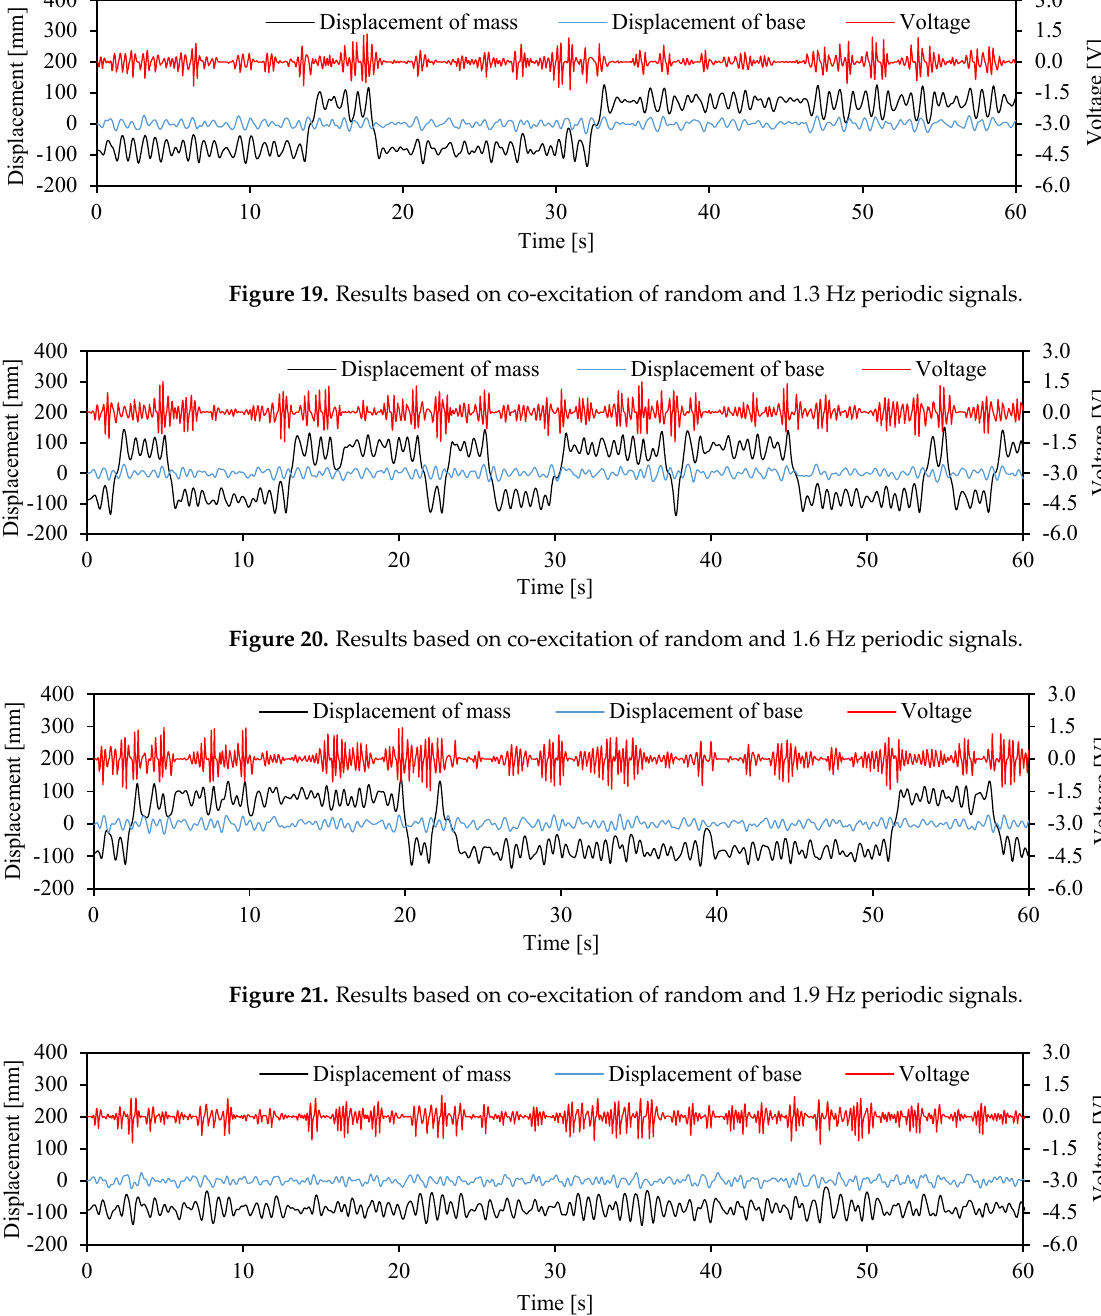
Figure 21. Results based on co-excitation of random and 1.9 Hz periodic signals. Figure 22. Results based on co-excitation of random and 2.2 Hz periodic signals.